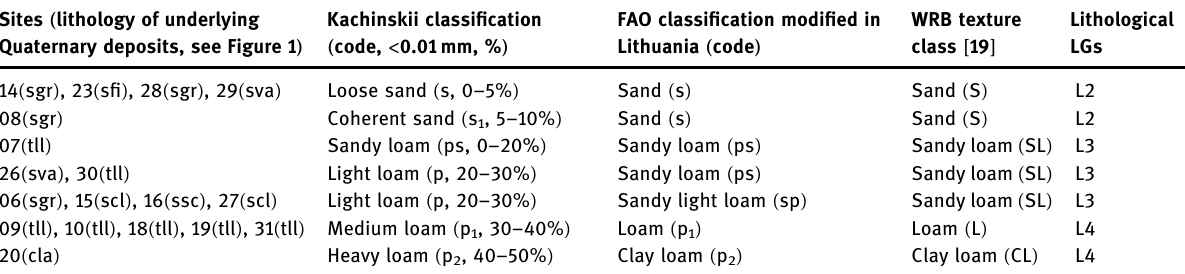
Table 2: Soil database information on soil parent material texture in sites, respective WRB texture classes and proposed LGs using L approach Sites ( lithology of underlying Quaternary deposits, see Figure 1